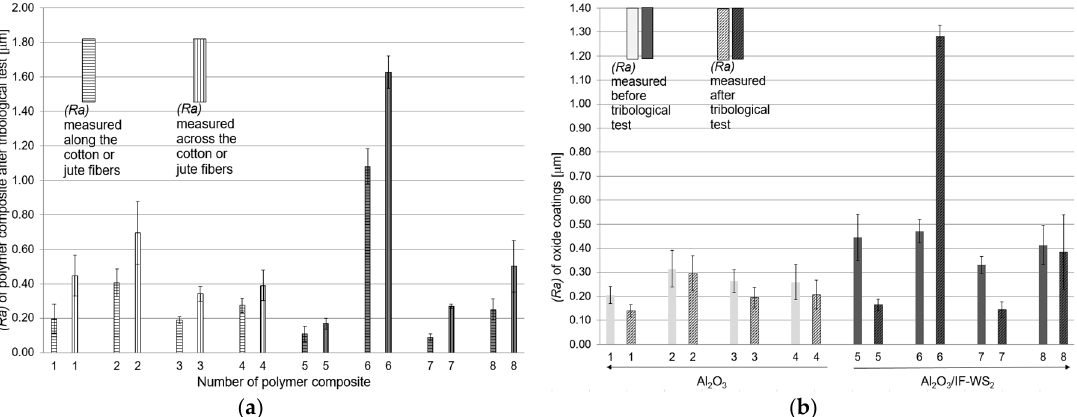
Figure 20. Roughness values ( Ra ) for: ( a ) the surface of the polymer composite pin after the tribological test and ( b ) aluminum oxide surfaces obtained in SAS and SAS / IF-WS 2 electrolyte before and after the tribological test.